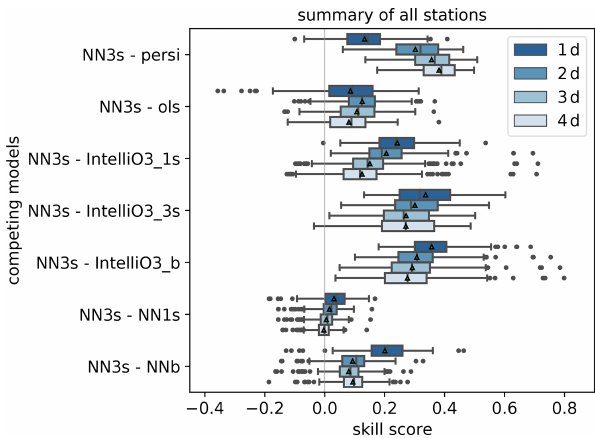
Figure 5. Estimated uncertainty of the mean squared error using block-wise bootstrapping (1000 realisations with replacement with block length of 7d). IntelliO3_* corresponds to the model architec- ture as presented in Kleinert et al. (2021) (IntelliO3-ts v1.0).